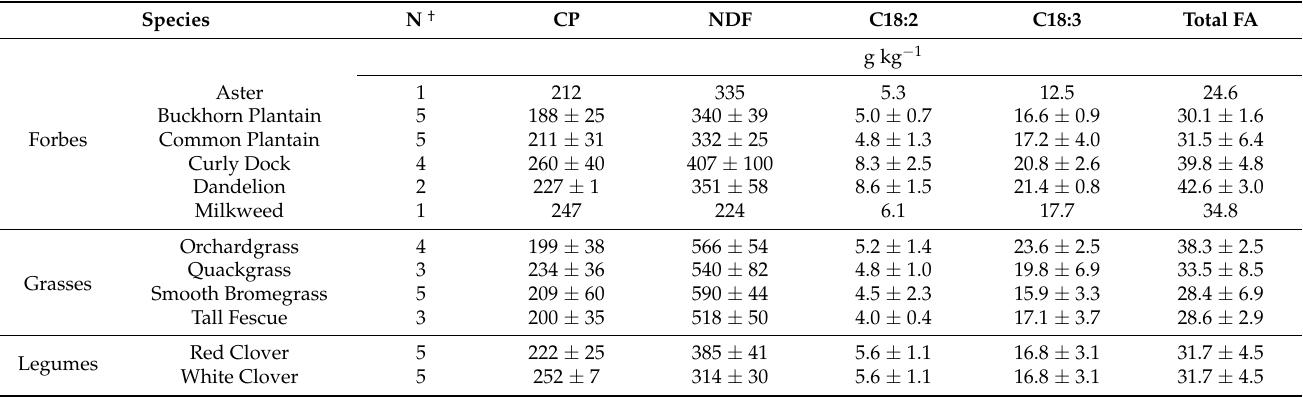
Table 1. Crude protein (CP), neutral detergent fiber (NDF), linoleic acid (C18:2), α -linolenic acid (C18:3), and total fatty acid (Total FA) content in forbs, grasses, and legumes consumed by livestock in West Virginia pastures (mean g kg − 1 dry matter ± SD).